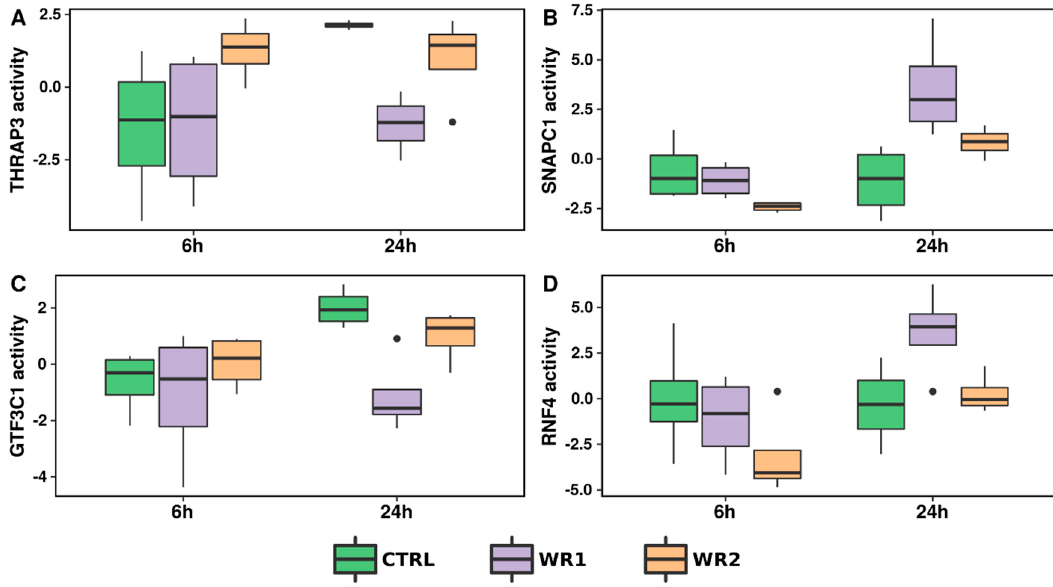
Figure 2. Nominally significant changes of transcription factor (TF) activity in separate comparisons of WR1 vs. WR2 group at 6 ( A ) or 24 h ( B – D ) time points. ( A ) THRAP3; ( B ) SNAPC1; ( C ) GTF3C1; ( D ) RNF4.